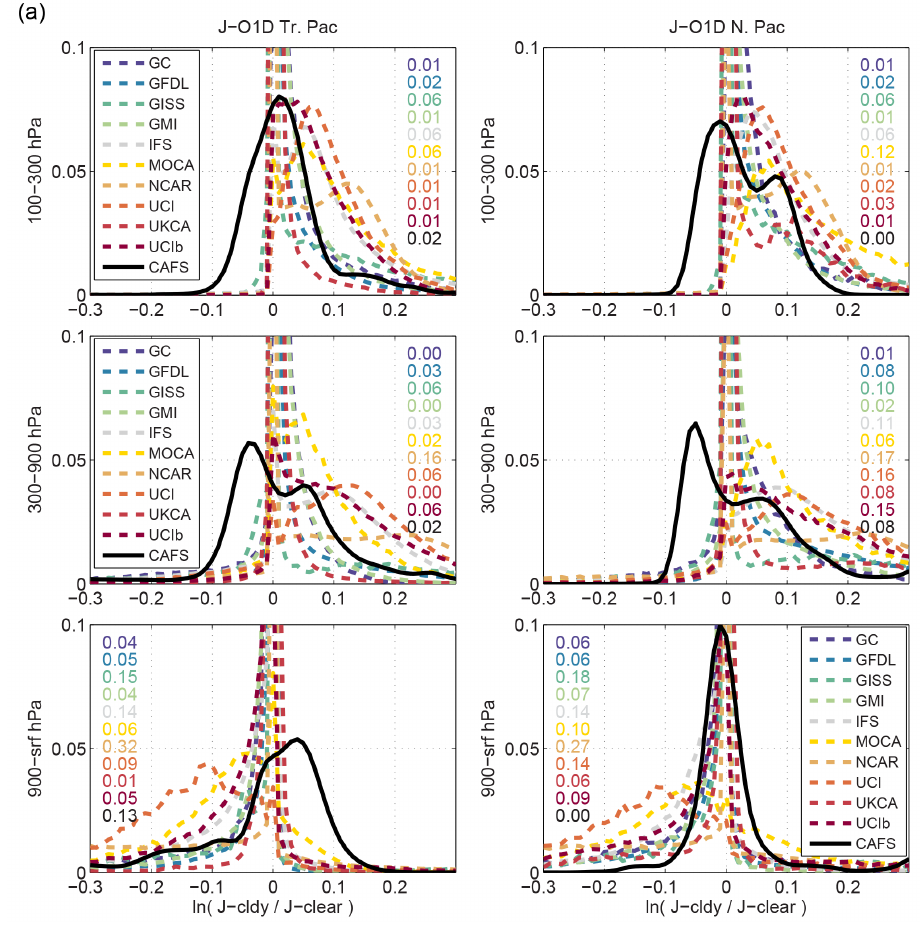
Figure 5a ( J -O1D) and b ( J -NO2) provide another view of the rlnJ statistics. Figure 5 has the same six blocks